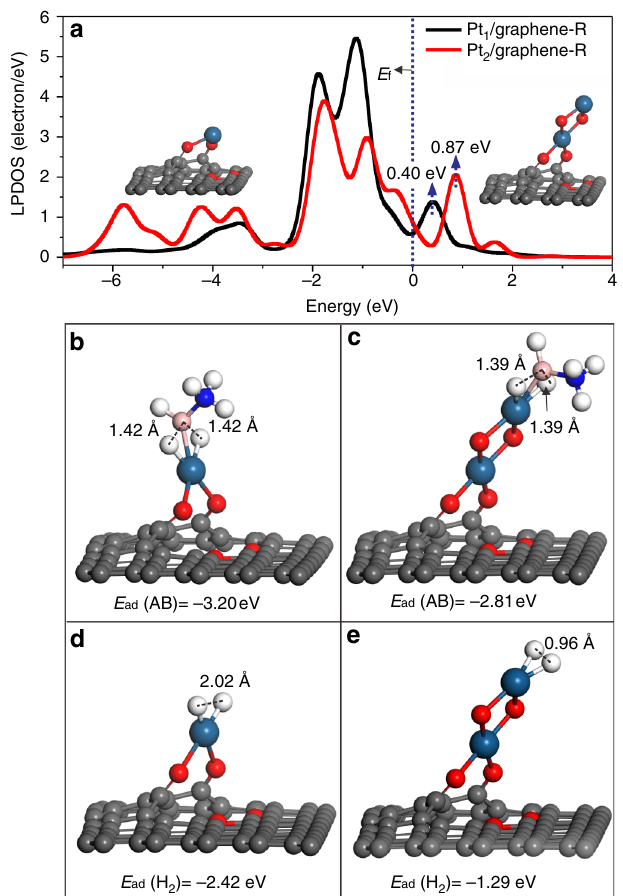
Fig. 5 Electronic properties as well as AB and H 2 adsorptions. a The local partial density of state (LPDOS) projected on the Pt 5 d orbitals of Pt 1 / graphene-R and the top Pt atom in Pt 2 /graphene-R. The local con fi gurations for AB adsorption on Pt 1 /graphene-R ( b ), Pt 2 /graphene-R ( c ). The local con fi gurations for H 2 adsorption on Pt 1 /graphene-R ( d ), Pt 2 / graphene-R ( e ). The ball in gray, white, pink, blue, red, and dark blue represent carbon, hydrogen, boron, nitrogen, oxygen, and